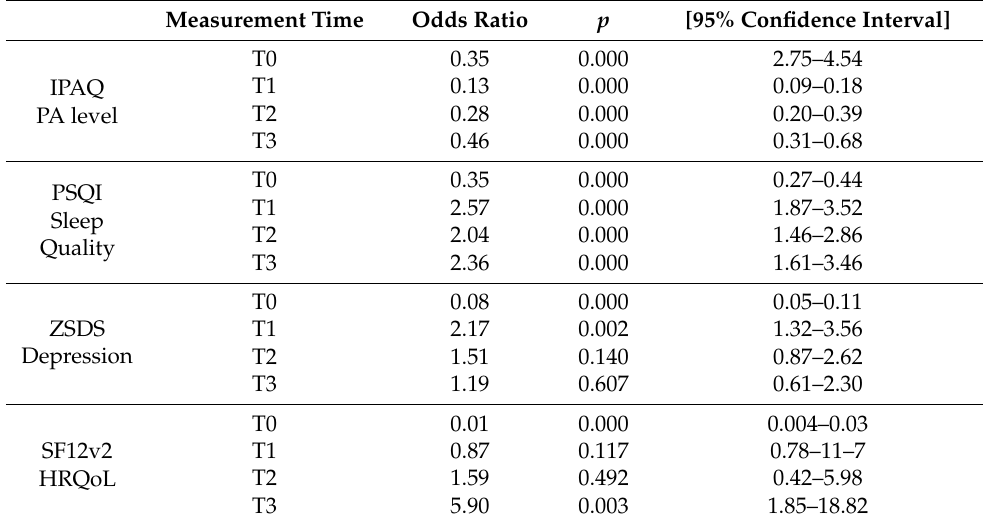
Table 6. Logistic regressions: associations of time with dichotomized